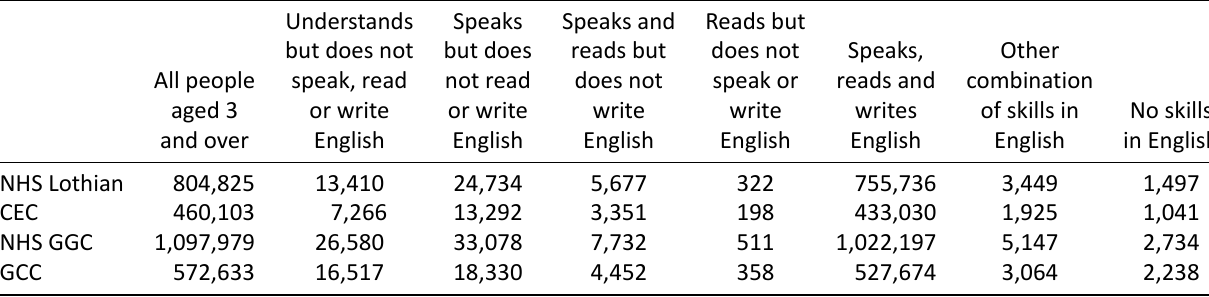
Table 1. 2011 Census: English language skills in the research